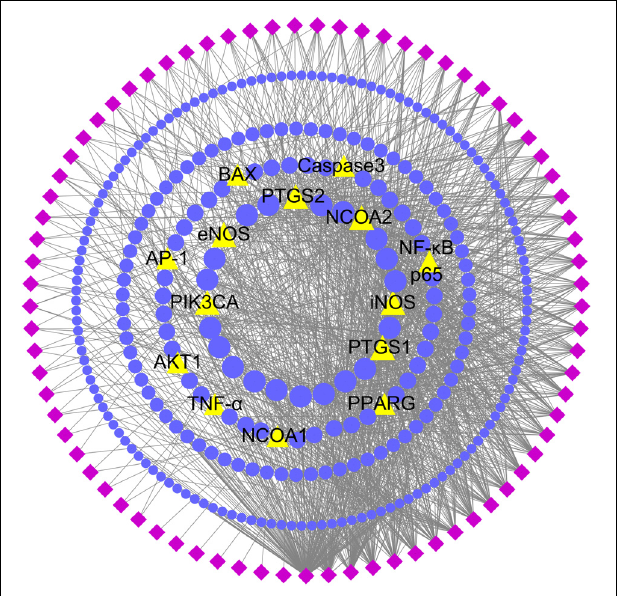
FIGURE 2 | Potential active ingredient-target network of DGLHD acting on hepatic fibrosis. The network was based on the interaction among active compounds in DGLHD, potential targets of DGLHD, and targets associated with liver fibrosis. Diamond nodes represent the potential active ingredients of DGLHD; circular nodes represent the potential targets of DGLHD; triangle nodes represent the overlap between potential targets of DGLHD and hepatic fibrosis-associated targets. The size of these targets is positively related to their degrees in the network.